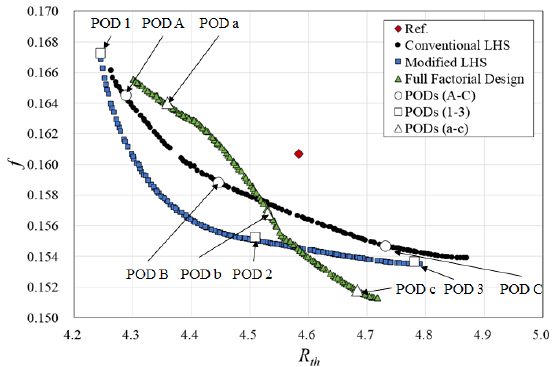
Figure 15. Pareto-optimal solutions for three different DOEs.